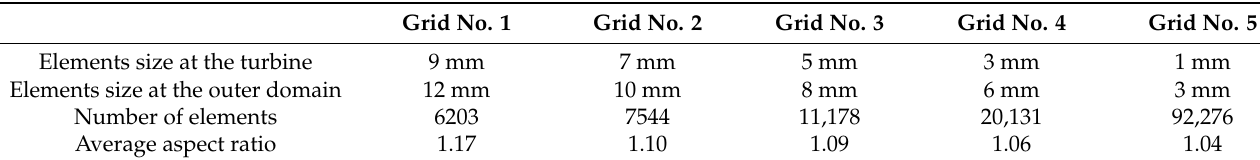
Table 2. Details of the mesh study using five grids.